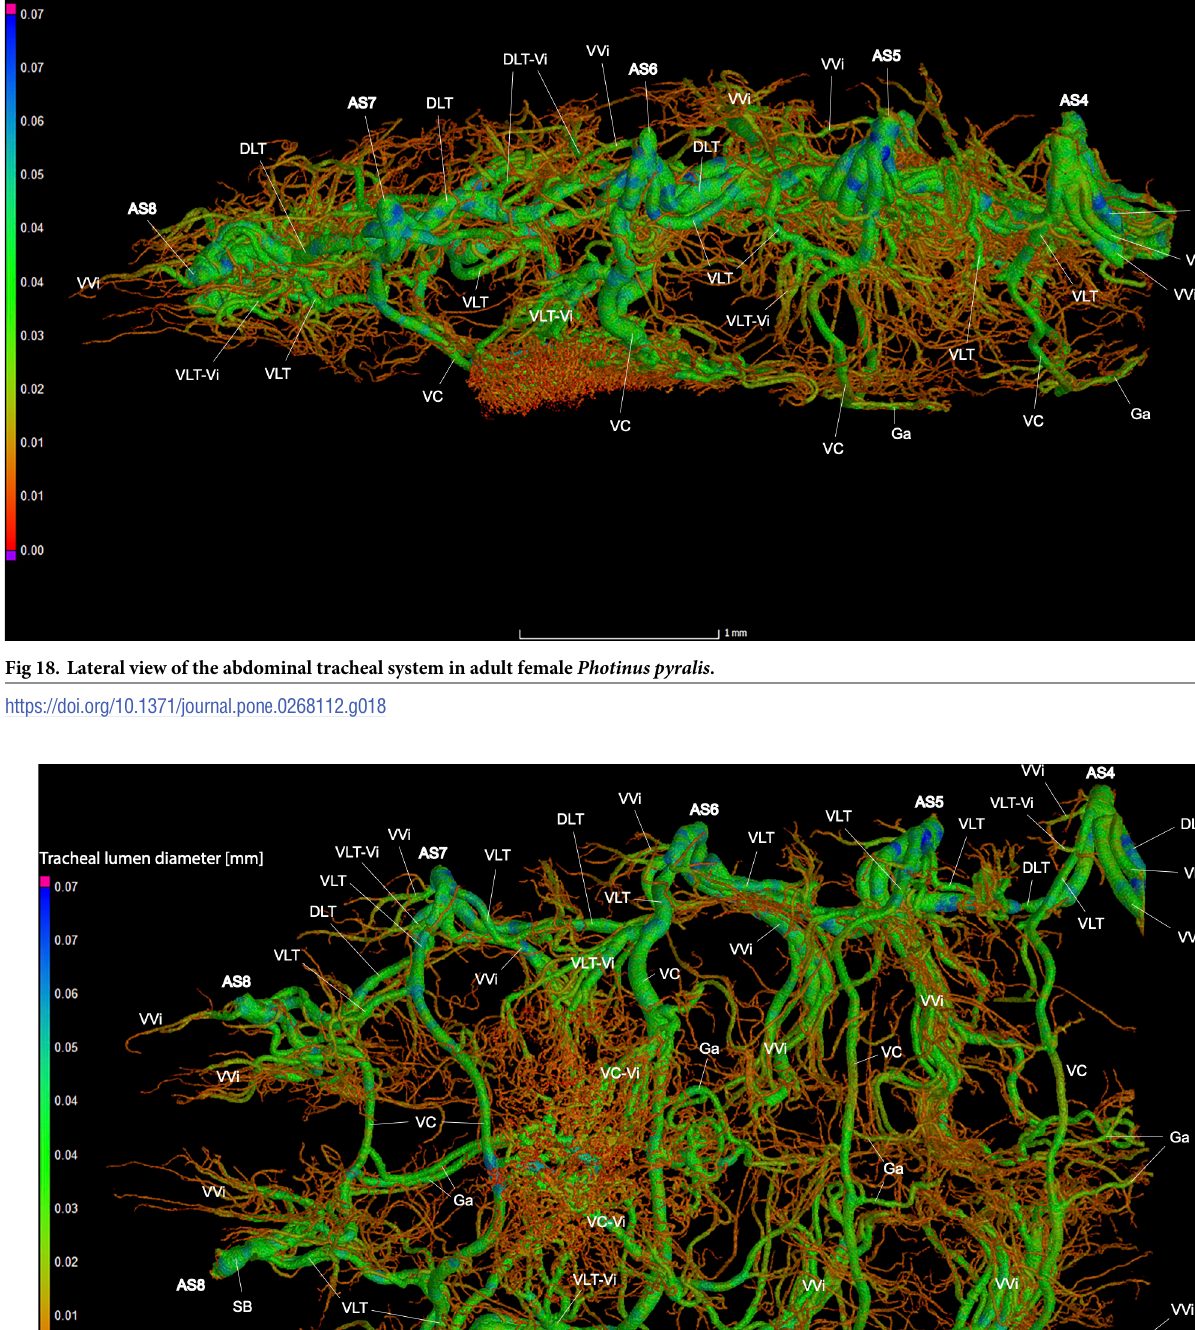
PLOS ONE | https://doi.org/10.1371/journal.pone.0268112 June 1,